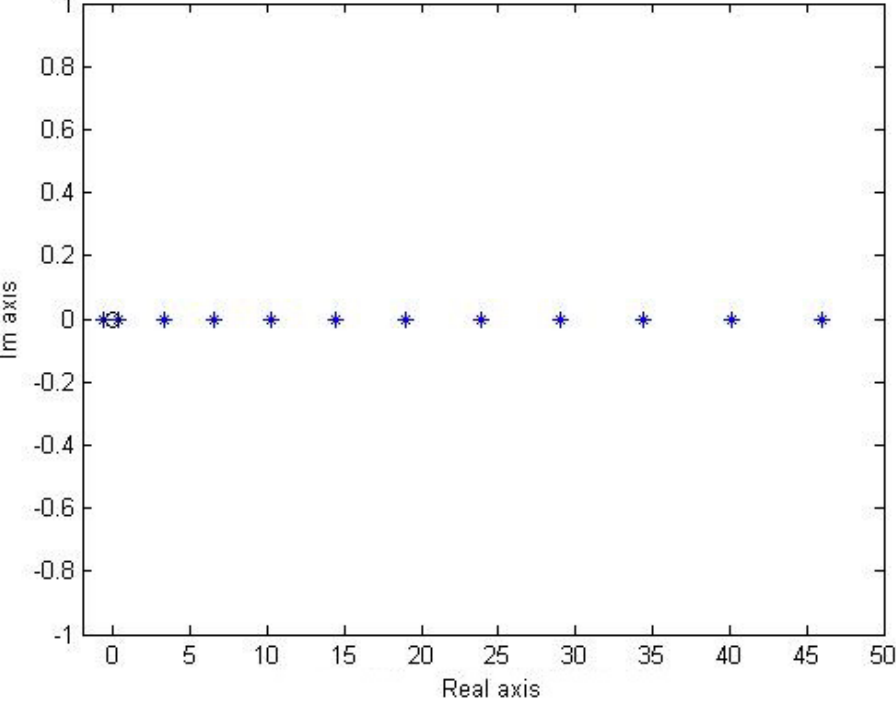
Figure 10. Energy eigenvalues of the PDM Hamiltonian associated with double well potential for λ = 1.0 .